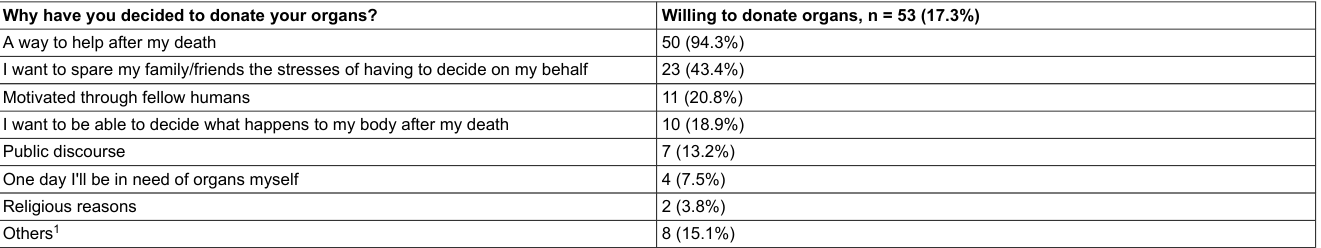
Table 3: Reasons for organ donation.